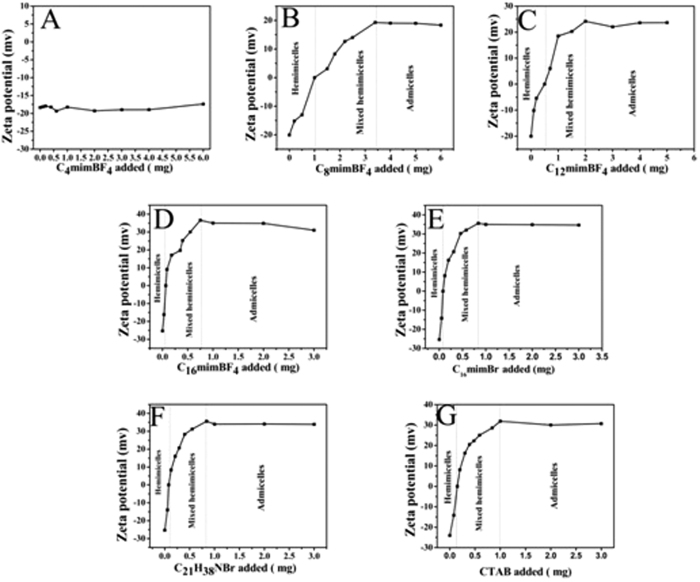
Zeta-potential of Fe3O4 NPs by adsorption of (A) C4mim BF4, (B) C8mimBF4, (C) C12mimBF4, (D) C16mimBF4, (E) C16mimBr, (F) C21H38NBr and (G) CTAB.